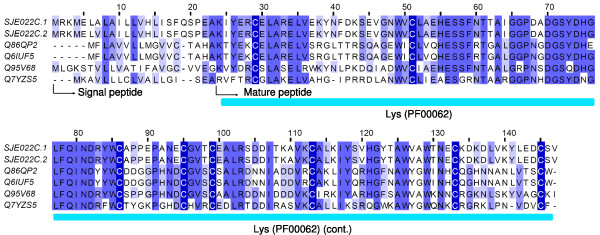
Sequence alignment of lysozymes. SJEs are clusters from this work. The others are Q86QP2 (Lysozyme, Branchiostoma belcheri tsingtauense), Q6IUF5 (Lysozyme C, Branchiostoma belcheri tsingtauense), Q95V68 (Lysozyme, Ornithodoros moubata), and Q7YZS5 (Lysozyme, Triatoma infestans).